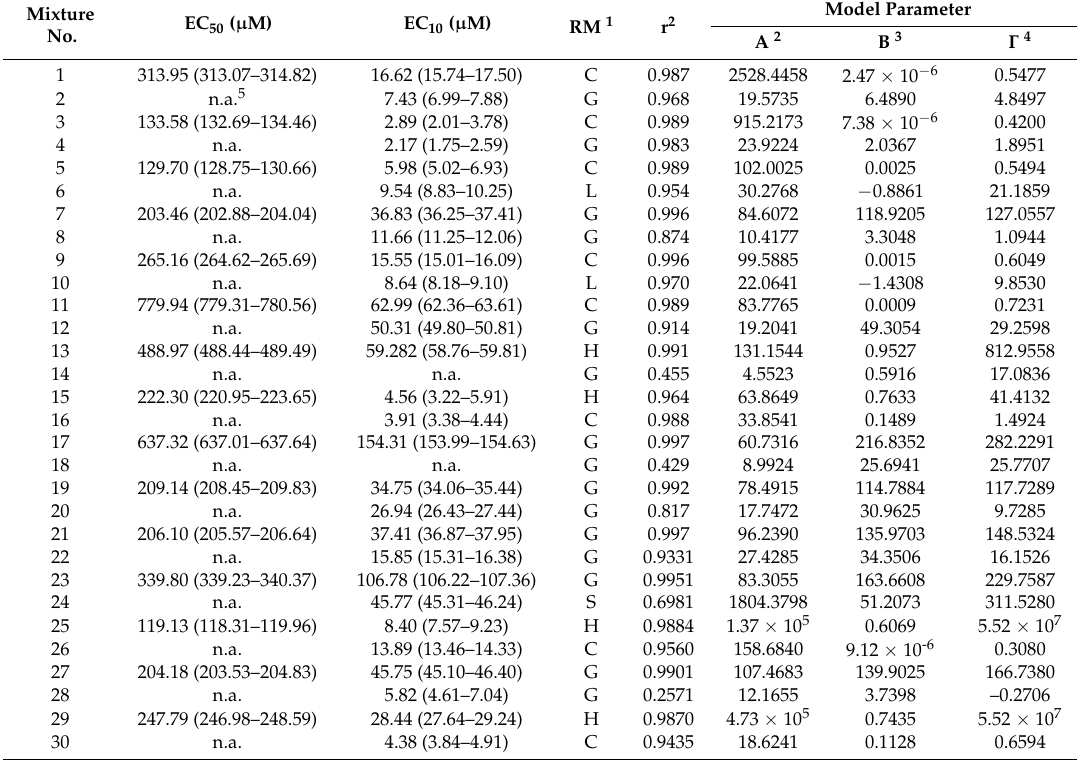
Table 3. Parameters of regression models for dose-response curves of 30 binary mixtures of pesticides and pharmaceuticals in Table 1 (the 95% confidence intervals are provided in the brackets). Mixture